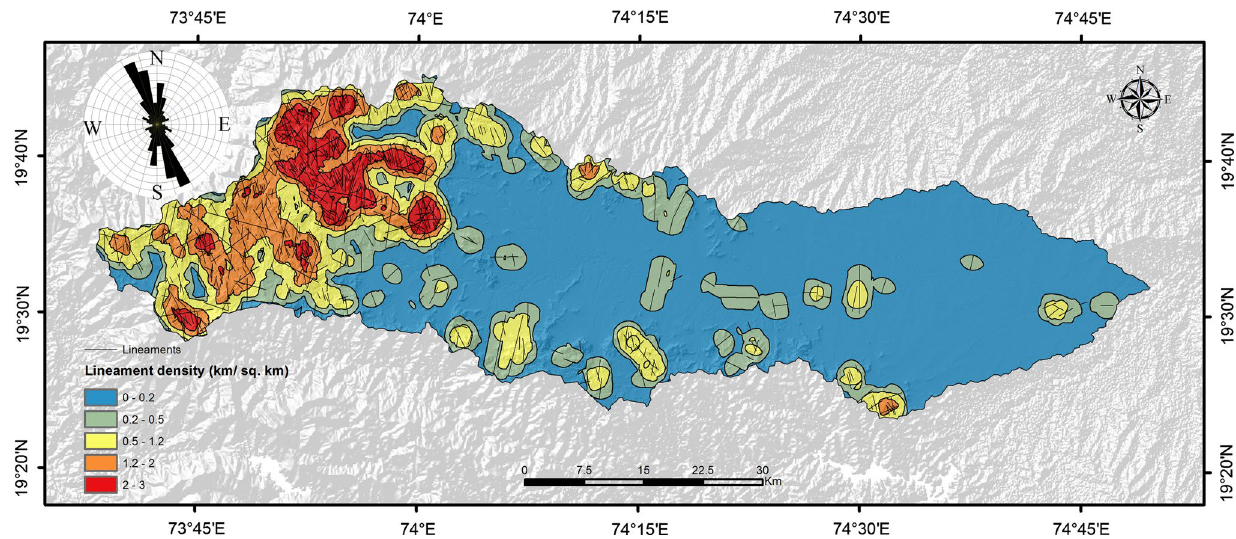
Fig. 9 Lineament density map of the study area. Straight lines are representing geological linear features in the study area. The inset rose dia- gram is illustrating the orientation of lineaments within Pravara basin (modified after Das et al. 2018)